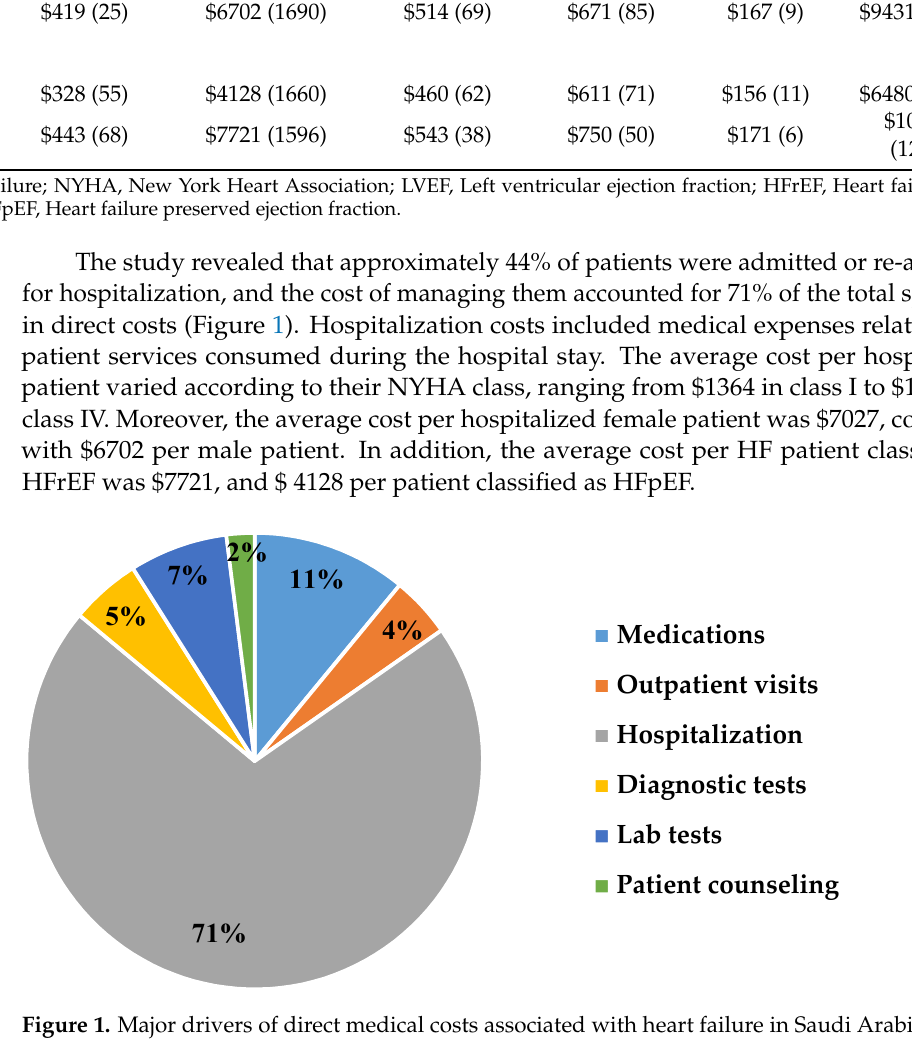
Figure 1. Major drivers of direct medical costs associated with heart failure in Saudi Arabia.